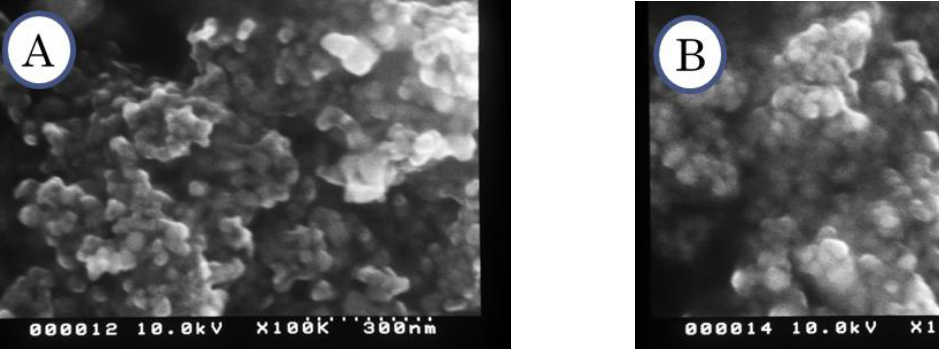
Figure 9. SEM images of TiO 2 ( A ) and Rh/TiO 2 ( B ).